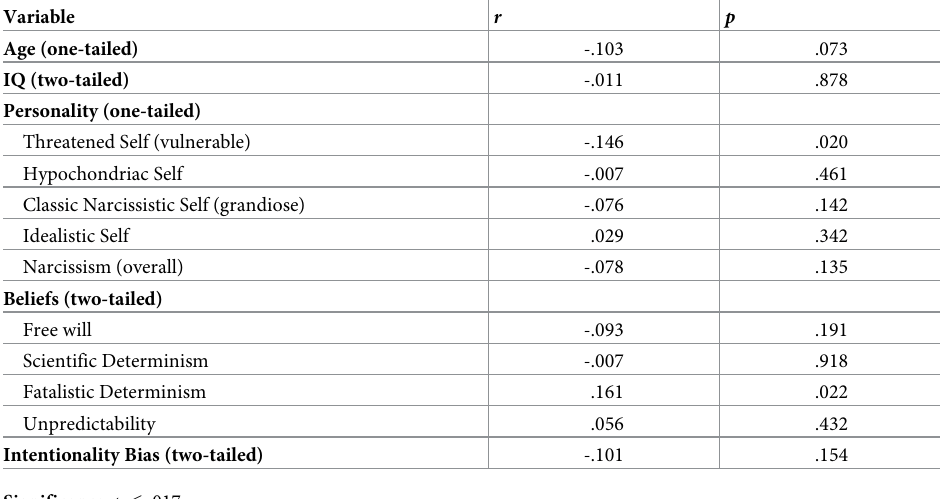
Table 1. Pearson Correlation Coefficients for determinants and sense of